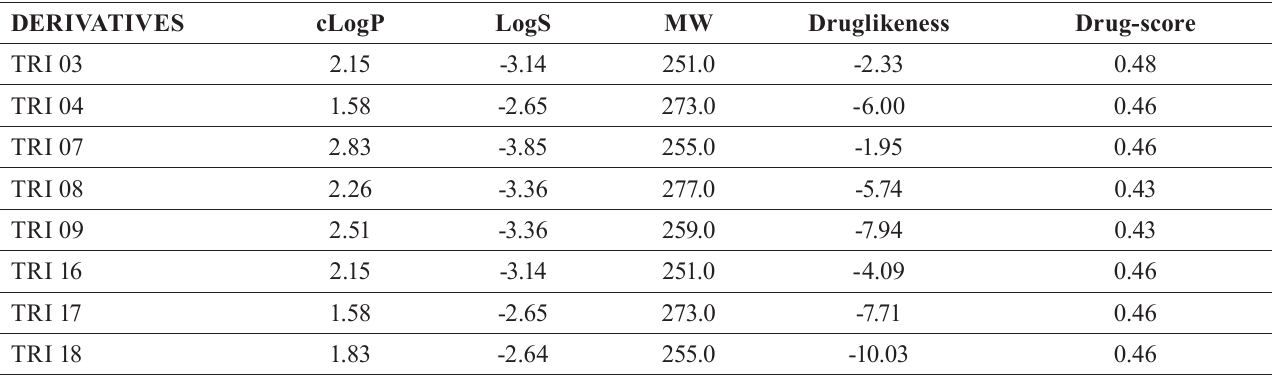
TABLE I - P rediction of theoretical toxicity of the 1,2,3-triazole derivatives DERIVATIVES